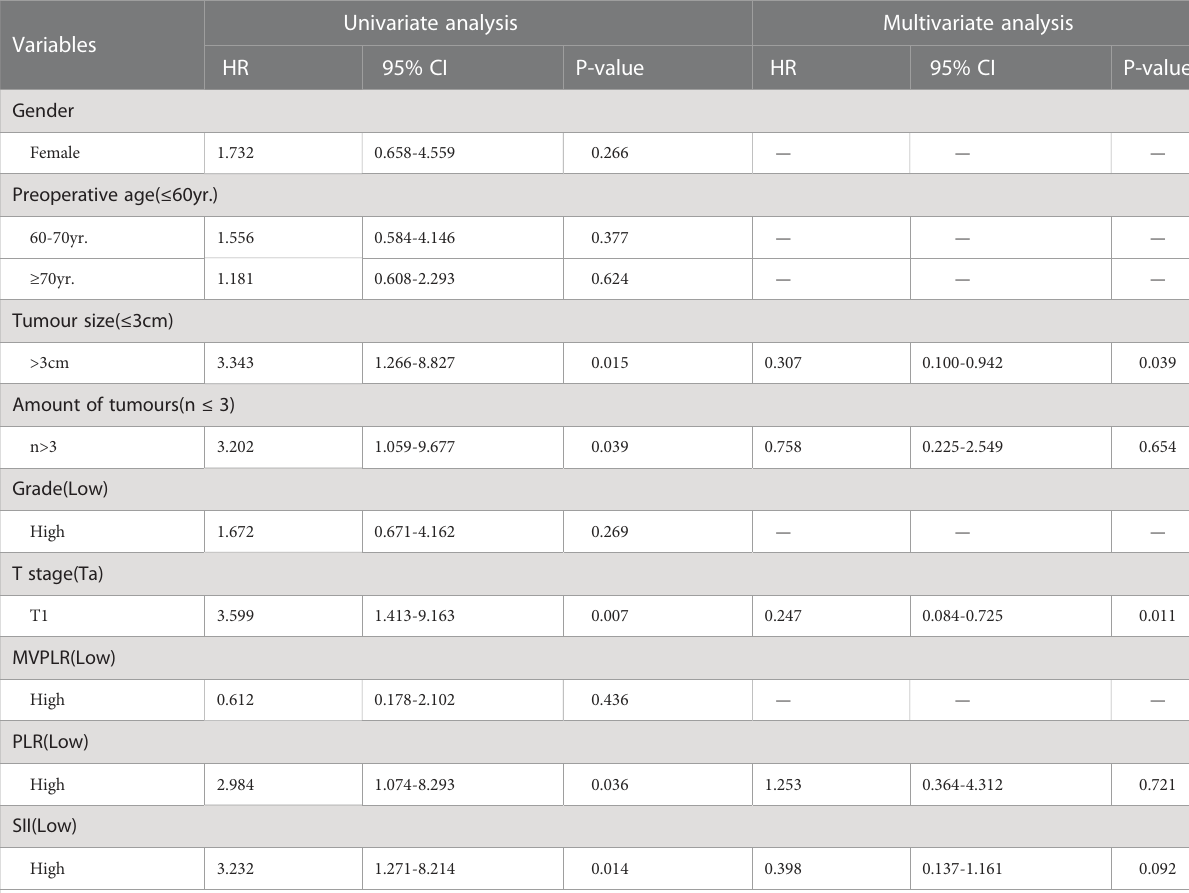
TABLE 5 Univariate and multivariate analysis with a Cox proportional hazard model of risk factors on RFS of the patients treated with intravesical CHT.